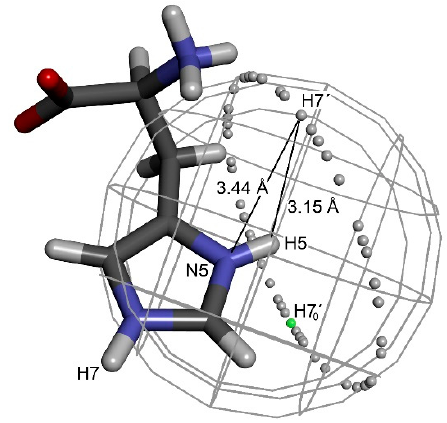
Figure 2. Definition of a sphere around H5 and its reduction to a circle.